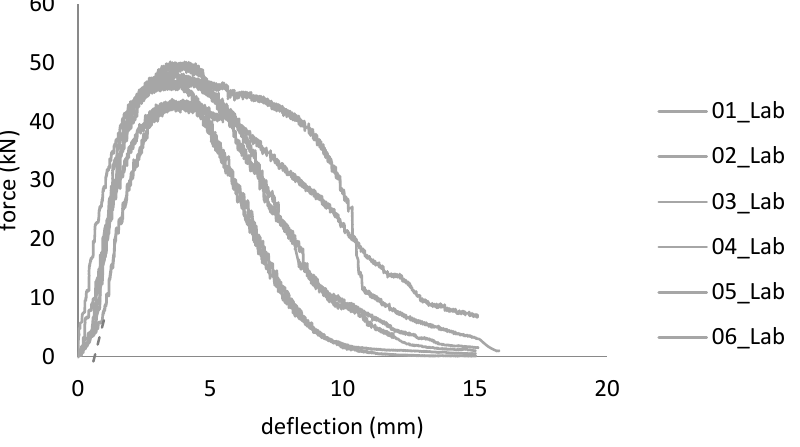
Figure 14. Load–deflection curves (_lab: cast in the laboratory).